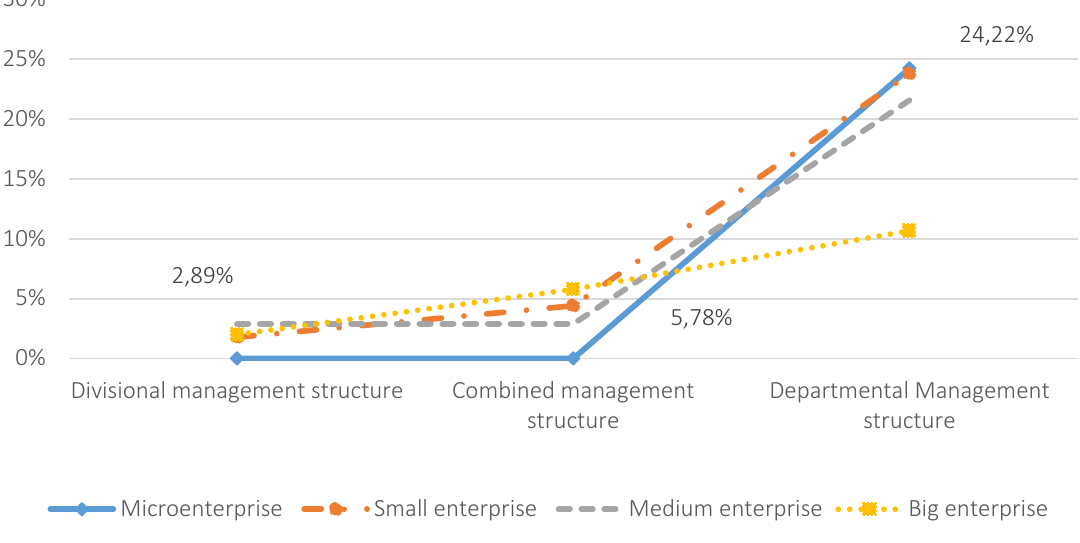
Figure 1. Percentage expression of dependence of a management organizational structure on the size of an enterprise